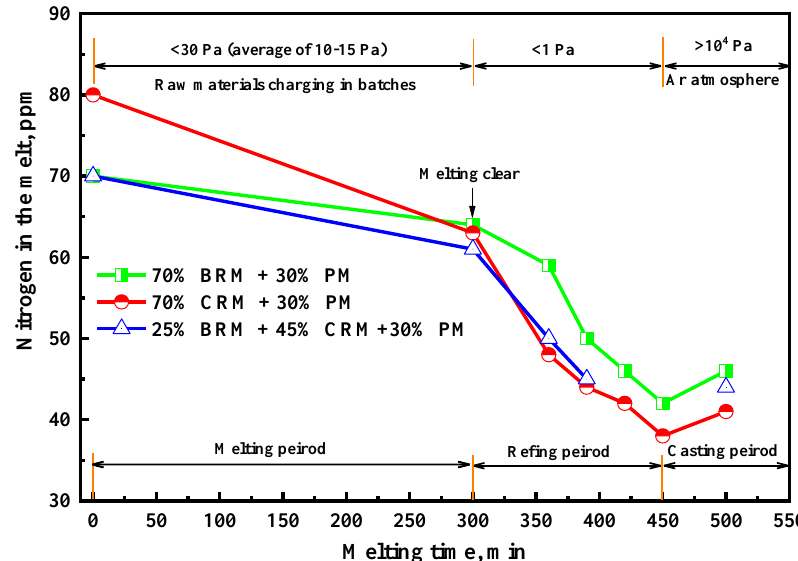
Figure 4. Change of nitrogen in the melt with smelting time. Figure 5 was obtained by the statistical treatment of the number density and average